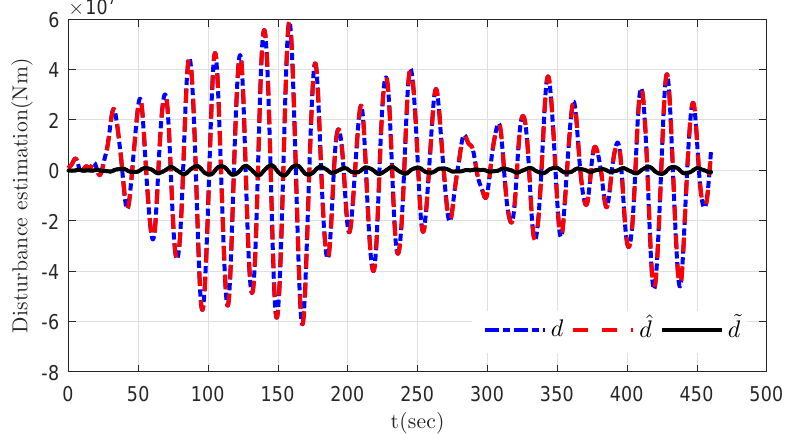
Figure 8. Disturbance estimation effect of the proposed ESO.